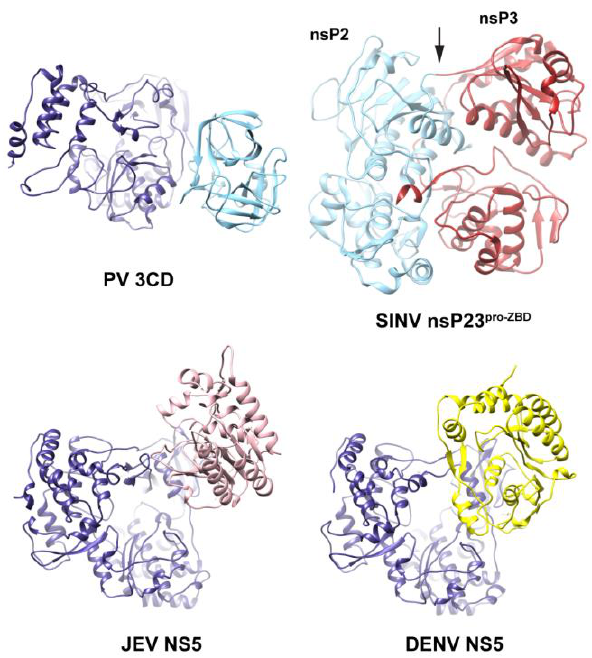
Figure 13. Interdomain interactions in PV 3CD and related proteins. Shown are the simulated structure of PV 3CD, structure of the polyprotein nsP23 pro-ZBD from Sindbis virus (SINV, PDB 4GUA), structures of NS5 proteins from Japanese Encephalitis Virus (JEV NS5, PDB 4K6M) and Dengue Virus (DENV NS5, PDB 4V0R). The polymerase domains are colored blue and the N-terminal domains (protease in PV and MTase in NS5) are shown in cyan, pink and yellow. The nsP2 and nsP3 domains are colored cyan and red, respectively. In the four proteins, interfaces between the N- and C-terminal domains exist. The interface in 3CD is a reminiscent of the interfaces observed in the above related proteins. In the structure of nsP23 pro-ZBD , extensive interdomain interactions between the nsP2 protease and the nsP2/3 domain are maintained. To process this polyprotein, a conformational change is required to expose the cleavage site, suggesting that multiple conformations may exist. In the JEV NS5 structure, the interactions between the N-terminal MTase and the C-terminal polymerase domains are mostly hydrophobic; whereas in DENV NS5 the interdomain interactions are mostly polar. This difference in the nature of the interface suggested that JEV NS5 may possess multiple conformations similar to what has been shown by SAXS for DENV NS5. An interesting difference between 3CD and NS5 is that the linker residues in 3CD (7 amino acids long) are sandwiched between the two domains whereas the linkers in NS5 are not. Note that the linker of JEV NS5 is longer than 3CD (10 amino acids long) and that of DENV NS5 is shorter than 3CD (4 amino acids long). Also, the linker residues in NS5 proteins are less conserved than the linker residues in 3CD.